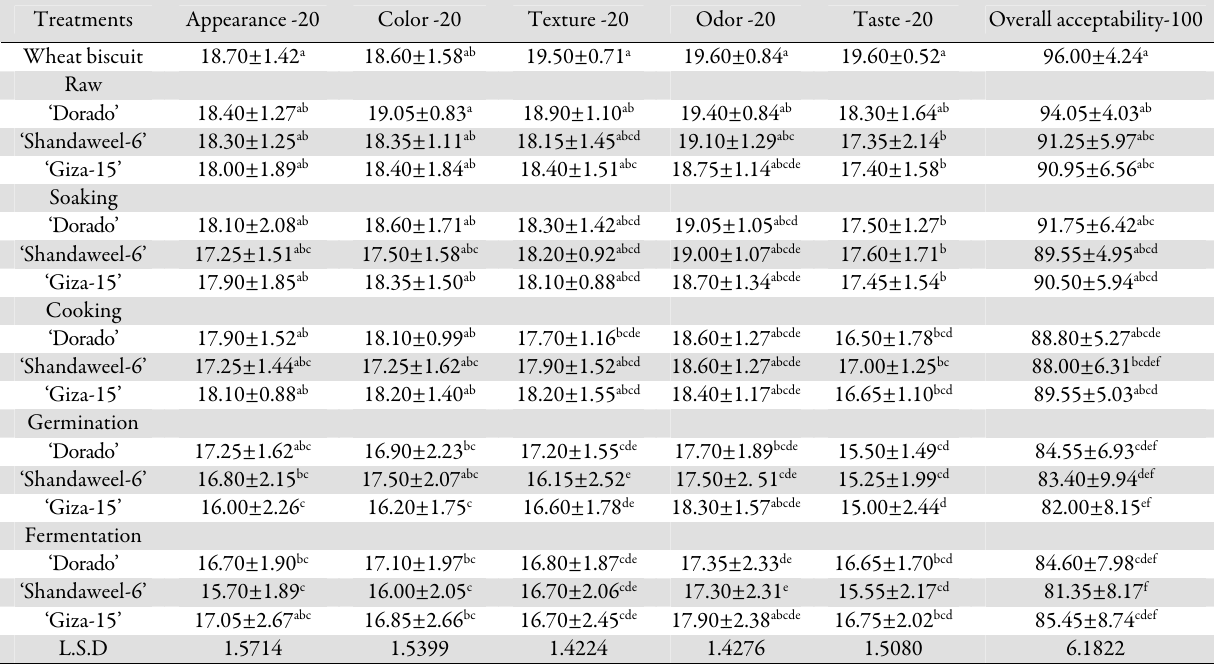
Table 4. Organoleptic evaluation of sorghum biscuits Treatments